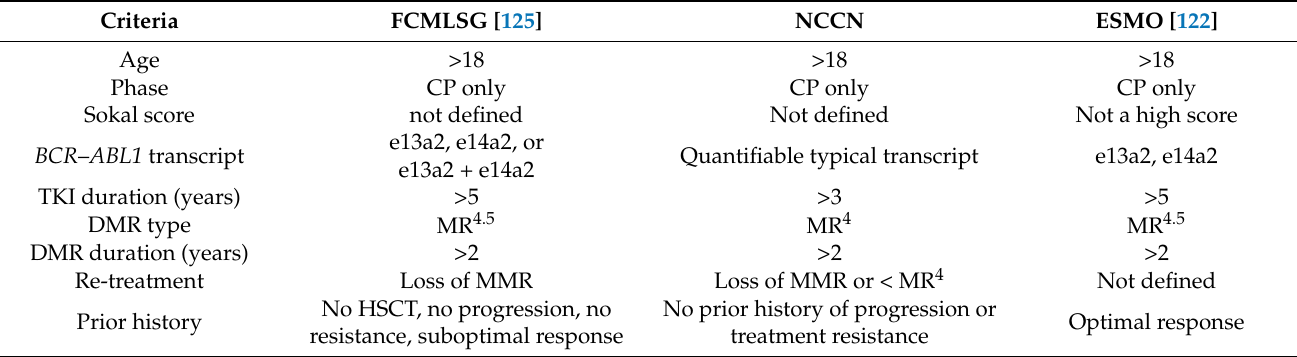
Table 2. Guidelines for TKI discontinuation in clinical